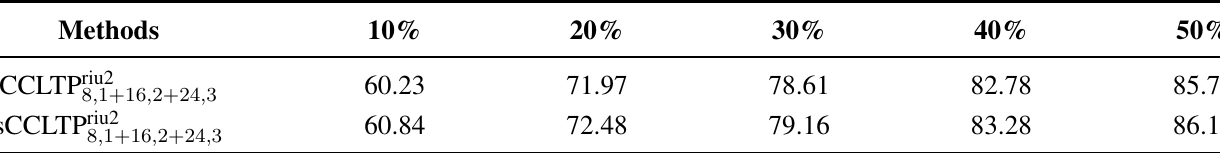
Table 5. Accuracy of infrared ATR (%) for SCCLTP and CCLTP under different training datasets.